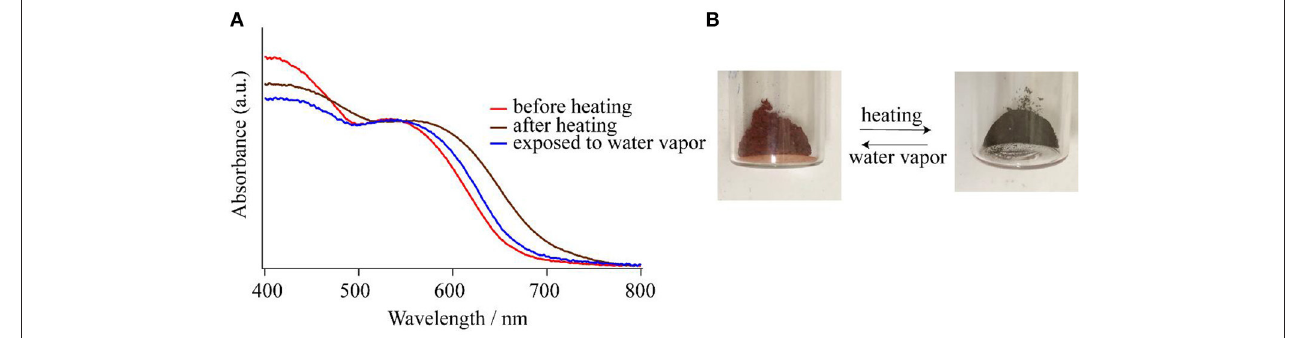
FIGURE 5 | (A) Reflectance spectra of 1-Br before heating (red line), after heating at 150 ◦ C (brown line), and after exposing to water vapor (blue line). (B) Photographs of the photochromism of 1-Br .